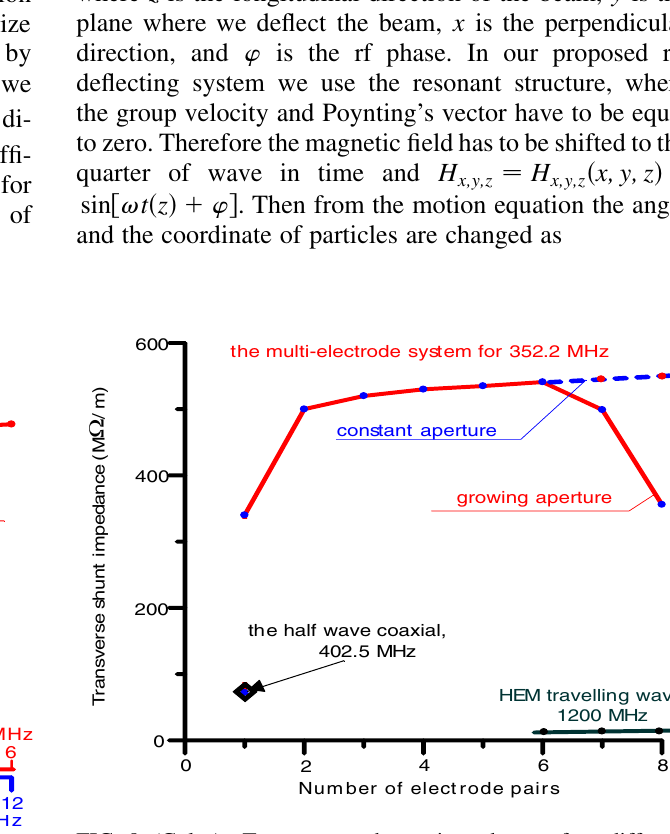
FIG. 7. (Color) Efficiency versus number of electrode